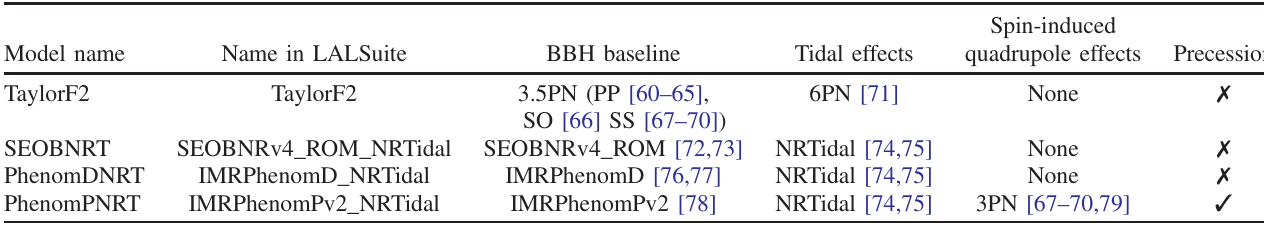
TABLE I. Waveform models employed to measure the source properties of GW170817. The models differ according to how they treat the inspiral in the absence of tidal corrections [i.e., the BBH-baseline — in particular, the point particle (PP), spin-orbit (SO), and spin- spin (SS) terms], the manner in which tidal corrections are applied, whether the spin-induced quadrupoles of the neutron stars [67 – 70,79] are incorporated, and whether the model allows for precession or only treats aligned spins. Our standard model, PhenomPNRT, incorporates effective-one-body (EOB)- and numerical relativity (NR)-tuned tidal effects, the spin-induced quadrupole moment, and